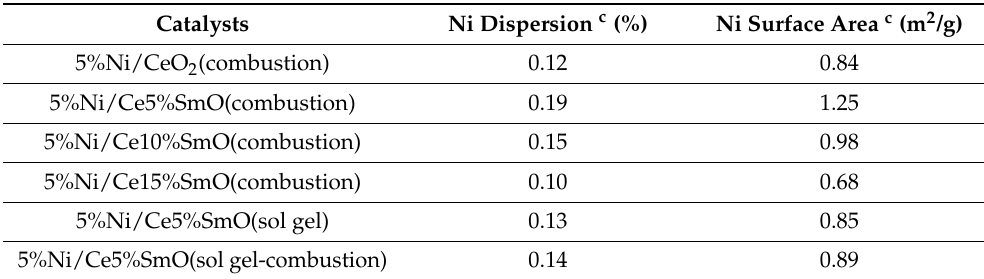
Table 2. The surface area and dispersion of metallic Ni prepared by different methods.